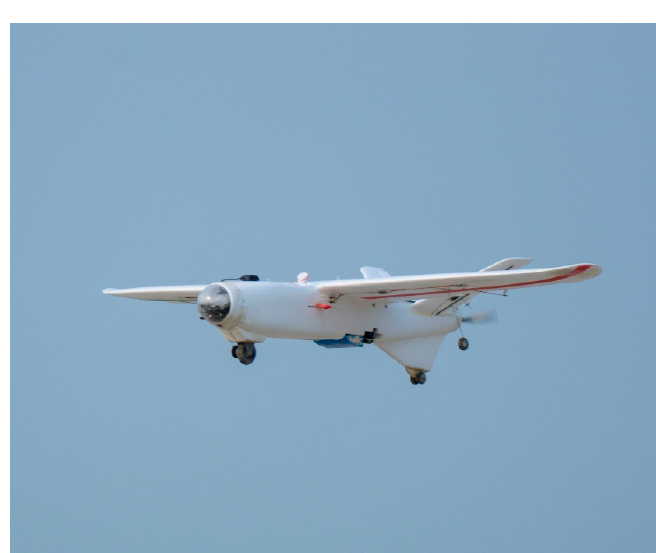
Figure 3. Overall View of X-UAV Talon [24].